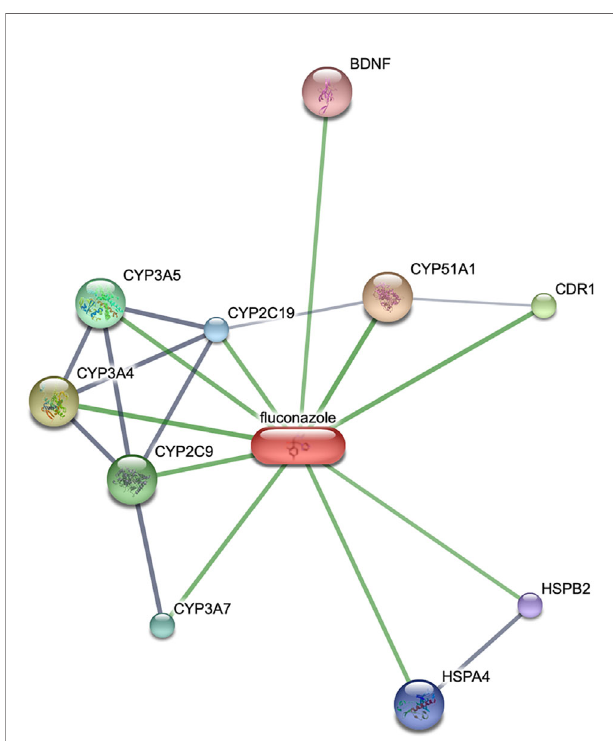
FIGURE 2 | Potential targets of fl uconazole and Cushing ’ s disease from STITCH. The node size re fl ects the degree of relationship: the smaller the degree value, the smaller the node size